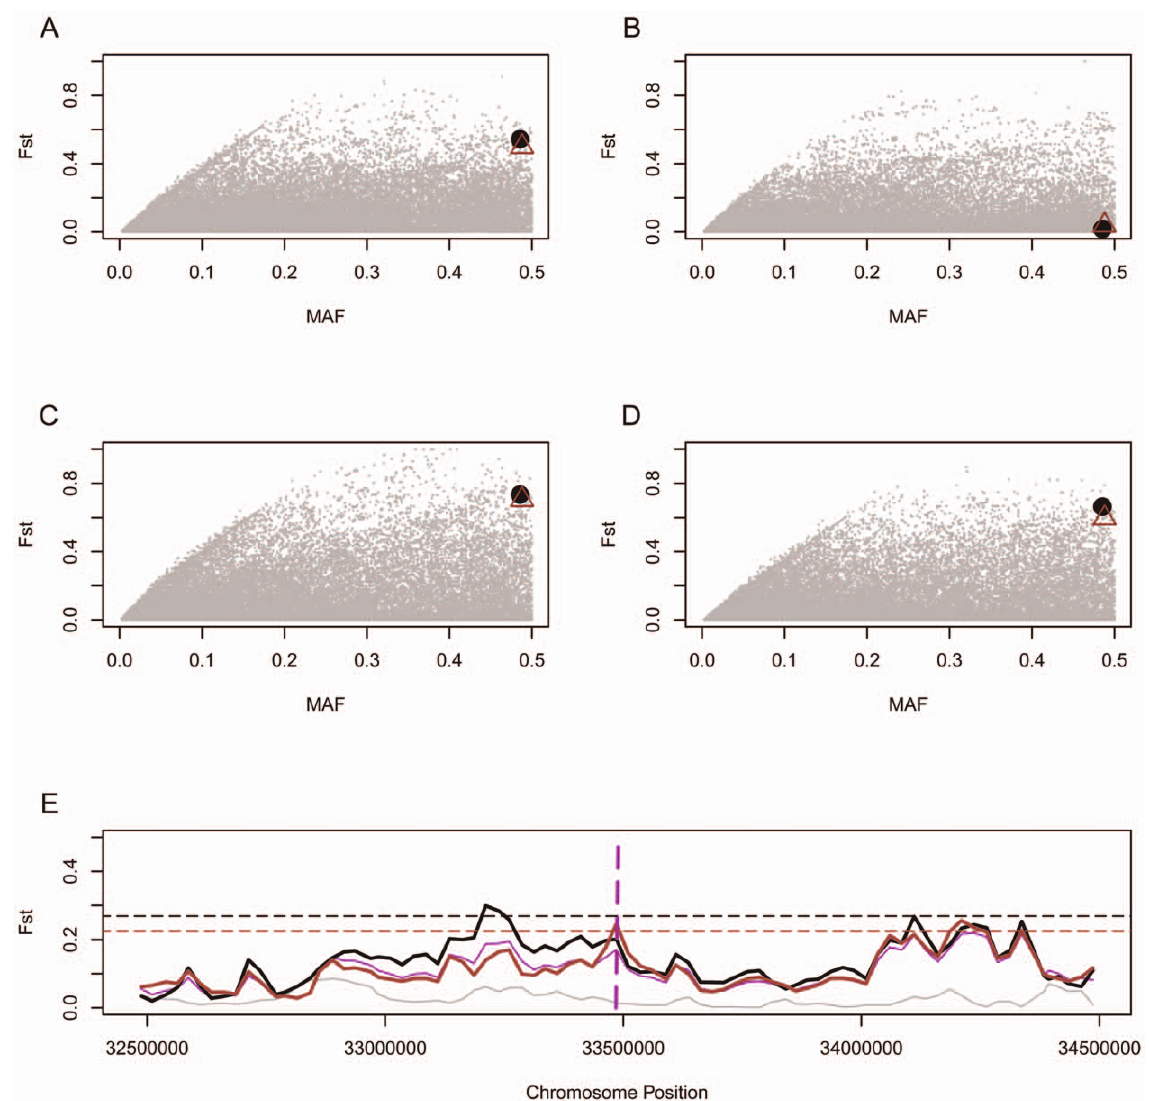
Figure 5. Fst distribution of SNPs across chromosome 20 gene regions. (A): Fst among the three populations vs minor allele frequencies (MAF). Big green dot and triangle represent SNPs rs143383 and rs143384. (B) Fst between East Asians and Europeans vs minor allele frequencies (MAF). (C) Fst between East Asians and Africans vs minor allele frequencies (MAF). (D) Fst between Africans and Europeans vs minor allele frequencies (MAF). (E) Sliding window analysis of Fst. Purple, black, brown and gray lines represent Fst among the three populations, Fst between East Asians and Africans, Fst between Africans and Europeans, Fst between East Asians and Europeans, respectively. The vertical line represents the position of GDF5 gene. Black and brown horizontal lines represent the 95% percentile rank values of Fst values between East Asians and Africans and Fst between Africans and Europeans, respectively.